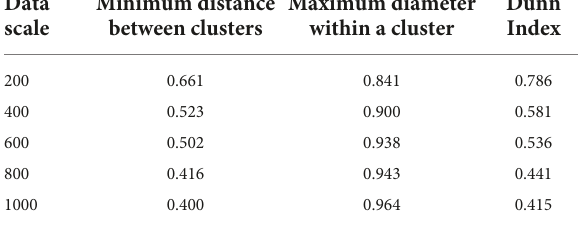
TABLE 4 Evaluation results of algorithms based on Jaccard cosine